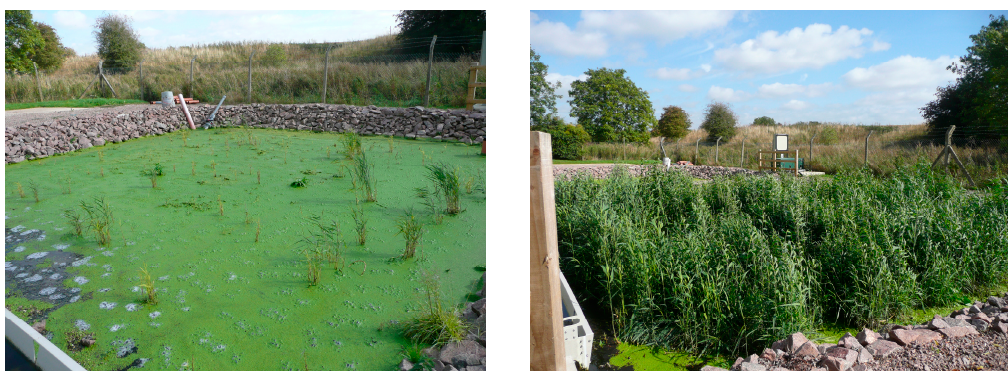
Figure 6. Plant establishment in aerated ( L ) and non-aerated ( R ) wetlands receiving a common influent.